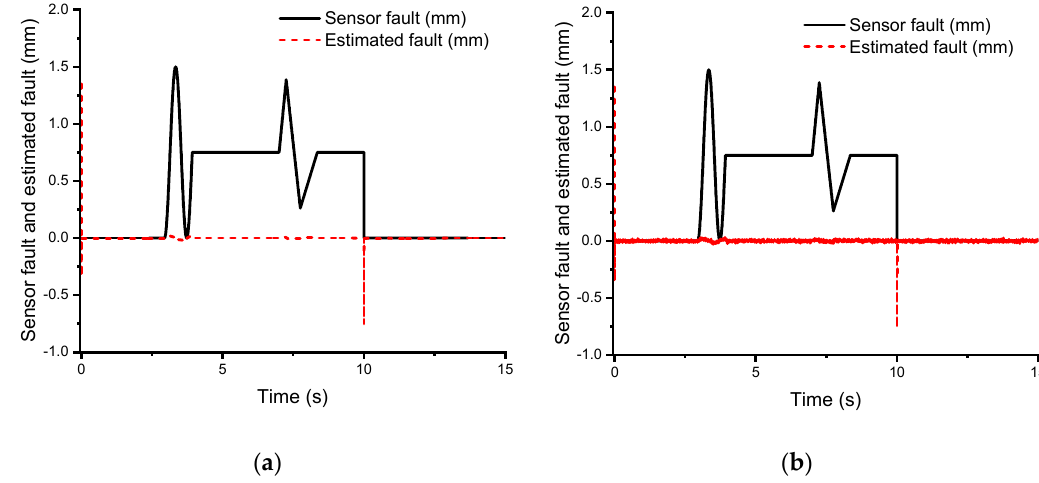
Figure 5. Position response and its estimation with SFTC ( a ) disturbance d k = 0, and ( b ) disturbance d k = 0.0045 random (2, t ).